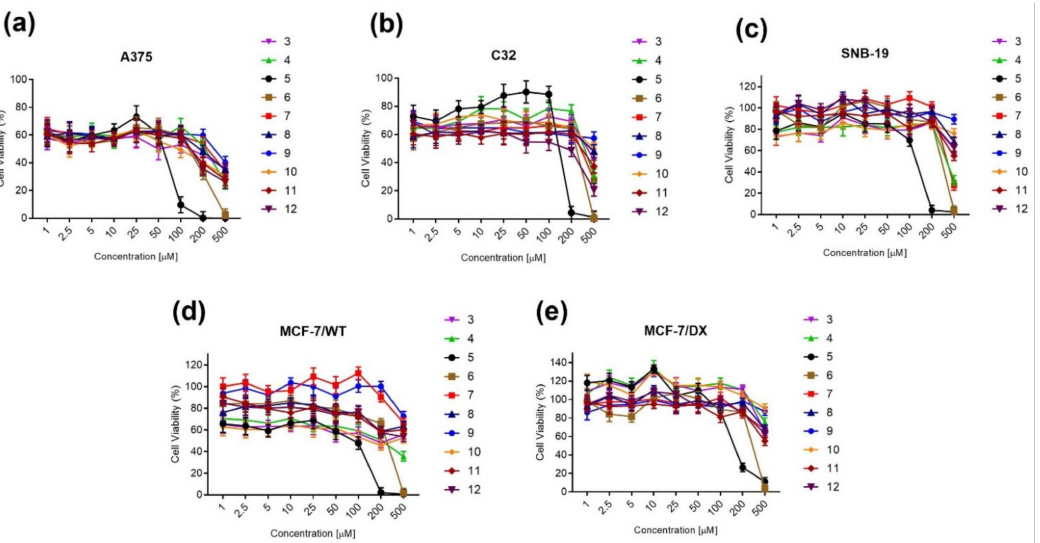
Figure 2. The cell viability after 24 h determined by the MTT colorimetric assay in ( a ) melanotic melanoma A375 cells, ( b ) amelanotic melanoma C32 cells, ( c ) glioblastoma SNB-19 cells, ( d ) breast adenocarcinoma MCF-7/WT cells and ( e ) drug-resistant breast adenocarcinoma MCF-7/DX